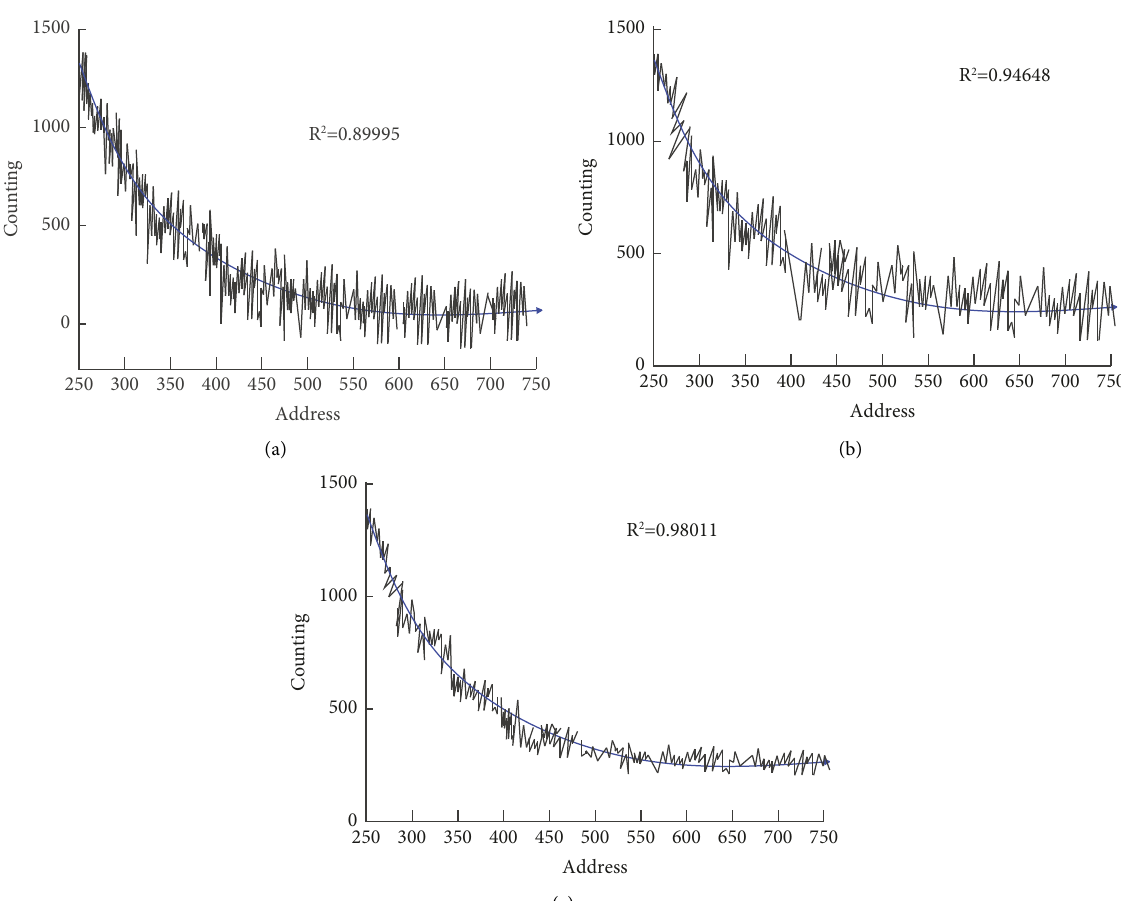
Figure 13: Filtering effect: (a) no smoothing filter effect; (b) 5-point smoothing filter effect; (c) S – K filtering effect.